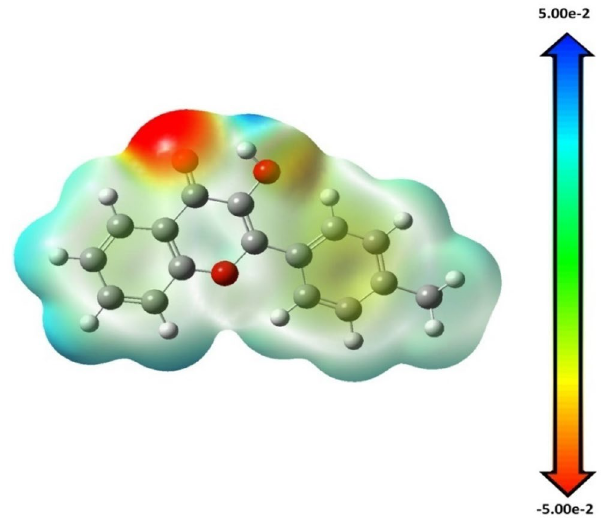
Figure 18. Molecular electrostatic potential map (MEP) calculated by B3LYP/6-31G(d,p)